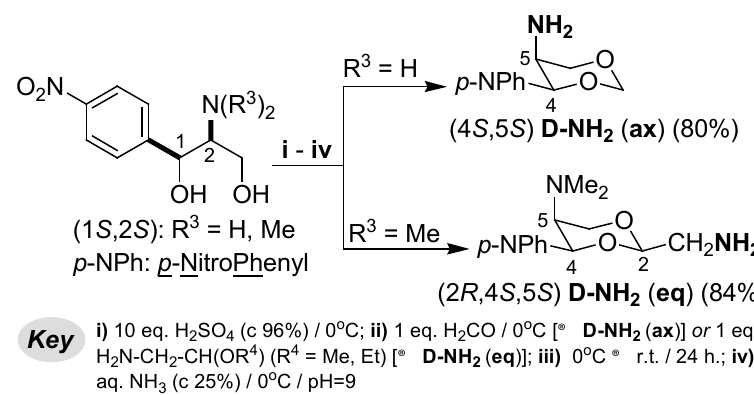
Scheme 2. Synthesis of p -nitrophenylserinols based amino-1,3-dioxanes as „ closed-chain ” unit by „sulphuric acetalisation“.